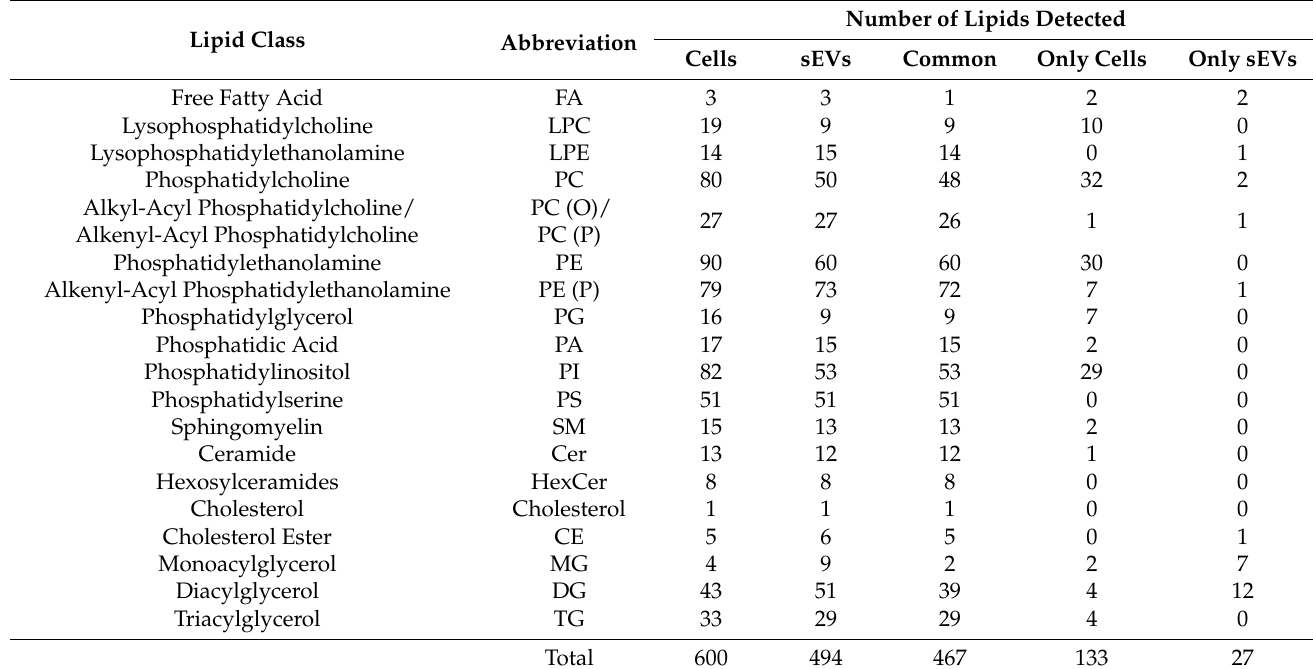
Table 2. Number of lipids of each class identified in cells and small extracellular vesicles (sEVs). Lipid